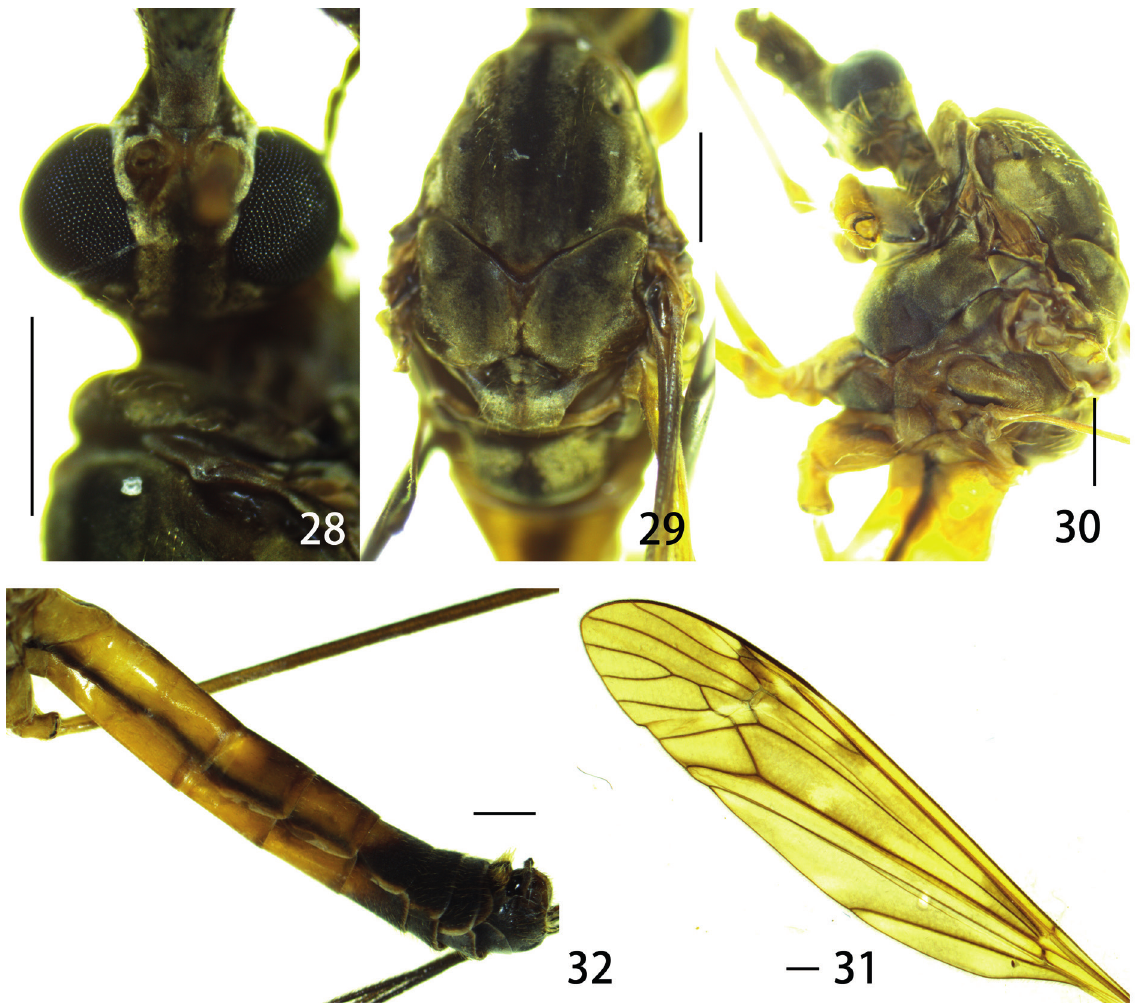
Figs 28–32. Tipula ( Vestiplex ) paramonovi sp. nov., ♂ , holotype (coll. Inse-XZ3769) . 28 . Head, dorsal view. 29 . Thorax, dorsal view. 30 . Thorax, lateral view. 31 . Wing. 32 . Abdomen, lateral view. Scale bars = 1.0